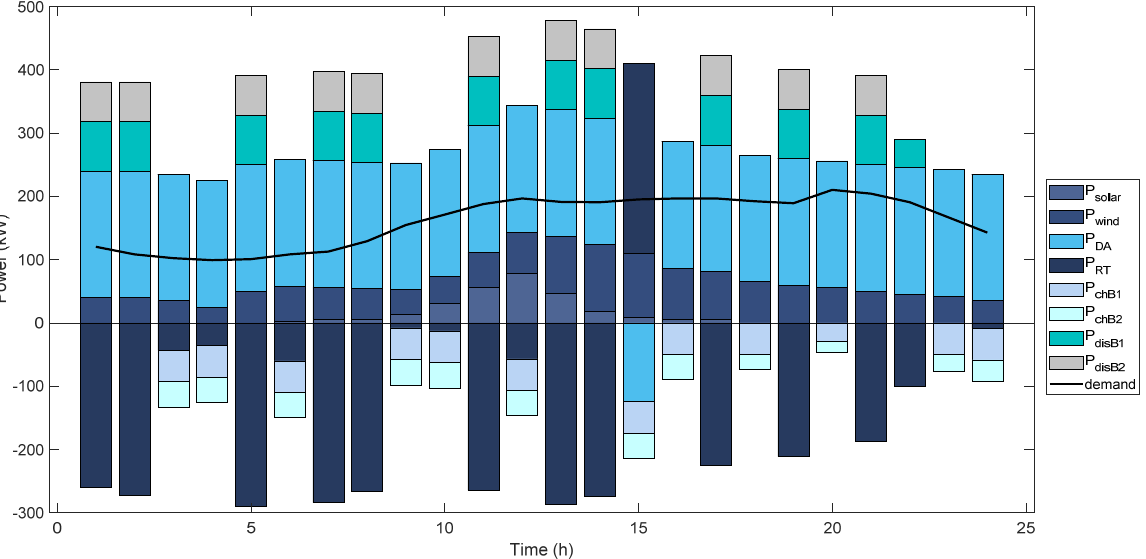
Figure 3. Optimal dispatch when the VPP participates in the RT market. Solar power ( P solar ) , wind power ( P wind ), power traded in DA ( P DA ), power traded in RT ( P RT ), battery charging power 1 ( P chB1 ) battery charging power 2 ( P chB2 ) , battery discharging power 1 ( P disB1 ) , battery discharging power ( P disB2 ) and demand power ( demand).